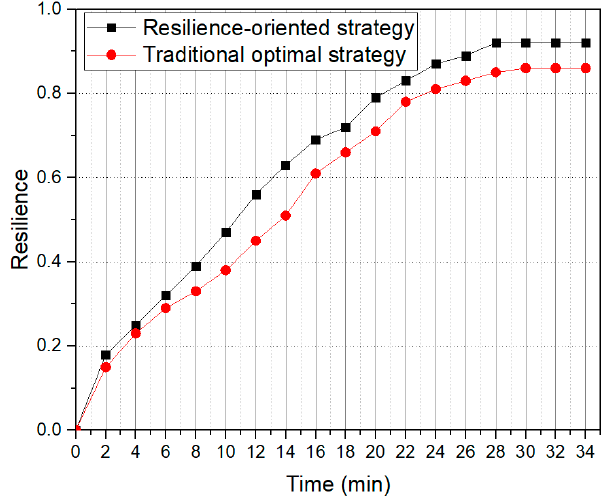
Figure 7. The optimal results of resilience.